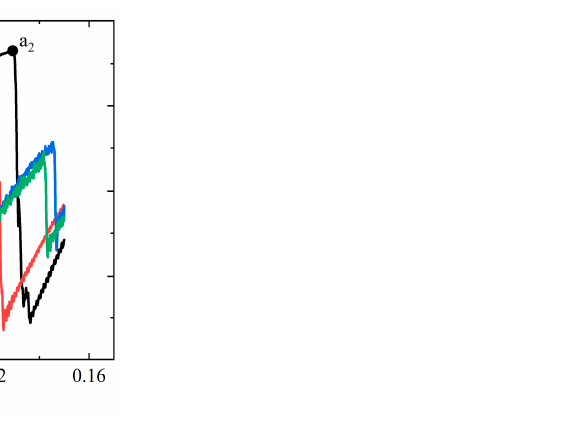
Figure 11. The stress-strain curves for single crystal Al-2%Mg alloys under uniaxial compression with different temperature. The four points, a 2 , b 2 , c 2 and d 2 , are the maximum stress at 10 K, 100 K, 300 K and 500 K, respectively.